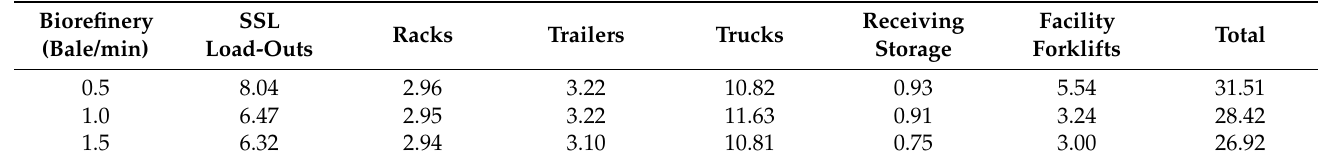
Table 7. Cost of unit operations for different capacity biorefineries (USD/Mg annual capacity).